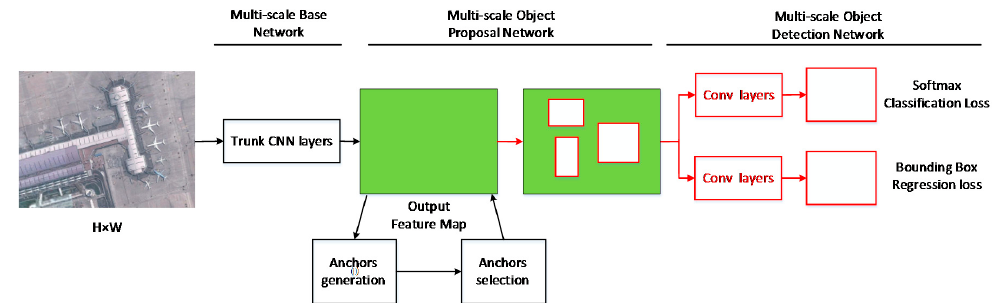
Figure 2. Architecture of the unified multi-scale CNN.